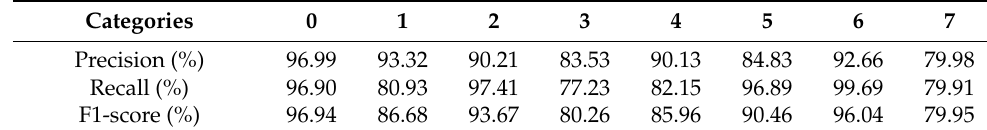
Table 6. Recognition effect of drilling multi-conditions based on Stacking model fusion.